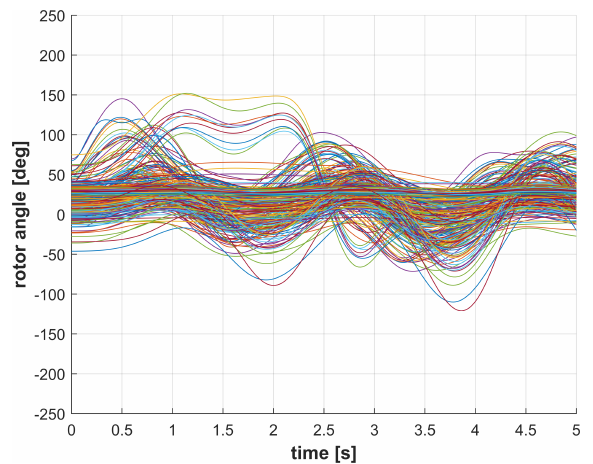
Figure 10. Rotor angles with D-FACTS control.